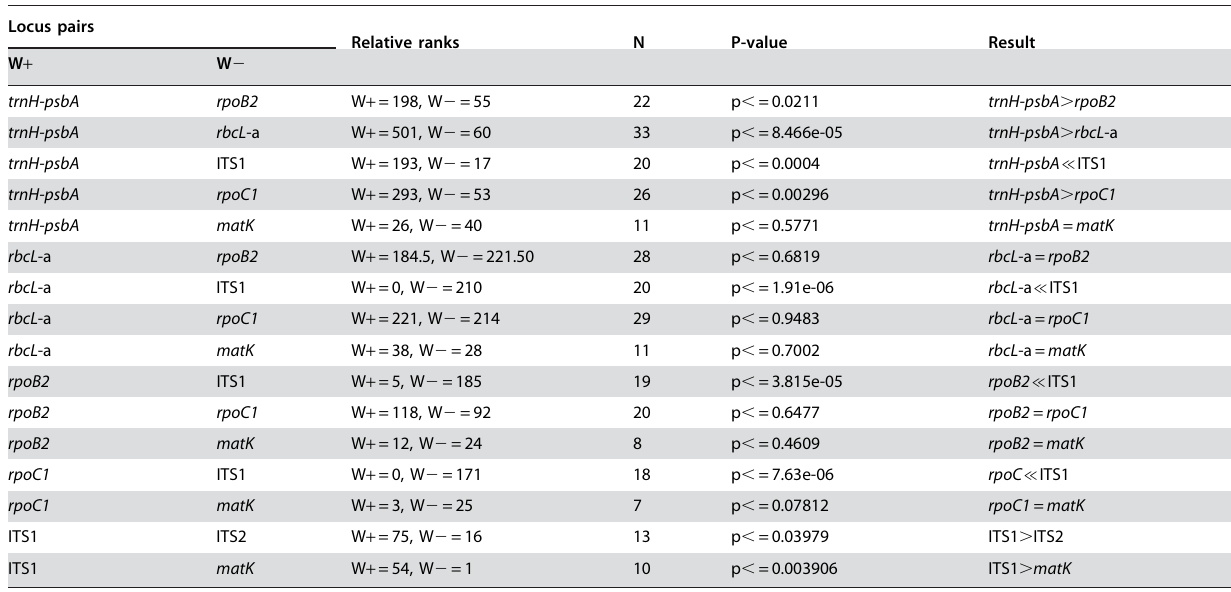
Table 2. Wilcoxon Signed rank tests of divergence among loci. .. ... .... ... ... .... ... ... .... ... ... .... ... ... .... ... ... .... ... ... .... ... ... .... ... ... .... ... ... .... ... ... .... ... ... .... ... ... .... ... ... .... ... ... . Locus